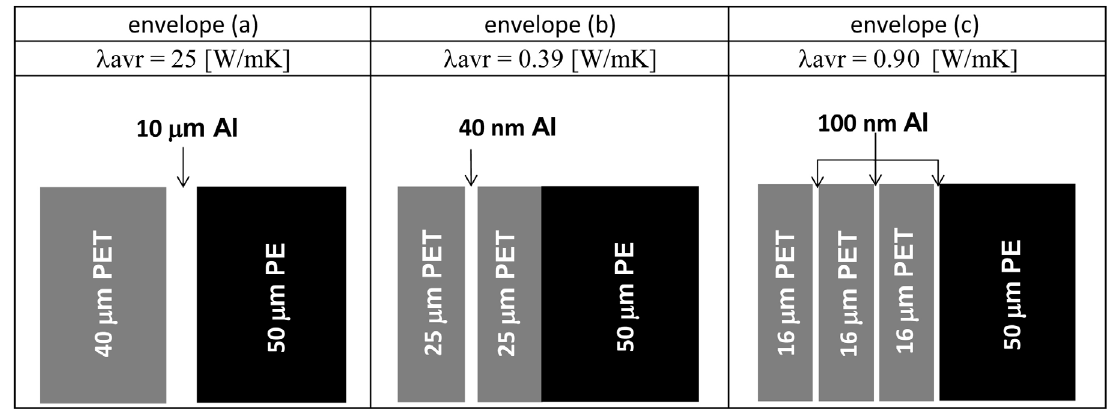
Figure 5. Envelope configurations considered for the numerical simulations [6].